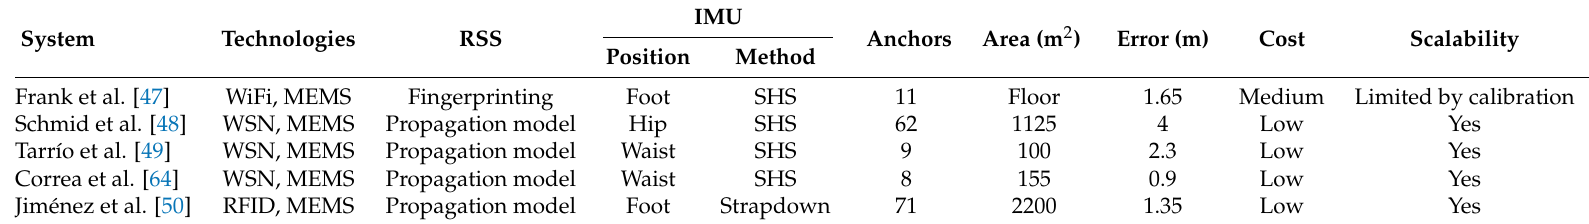
Table 3. RSS-IMU hybrid positioning systems.